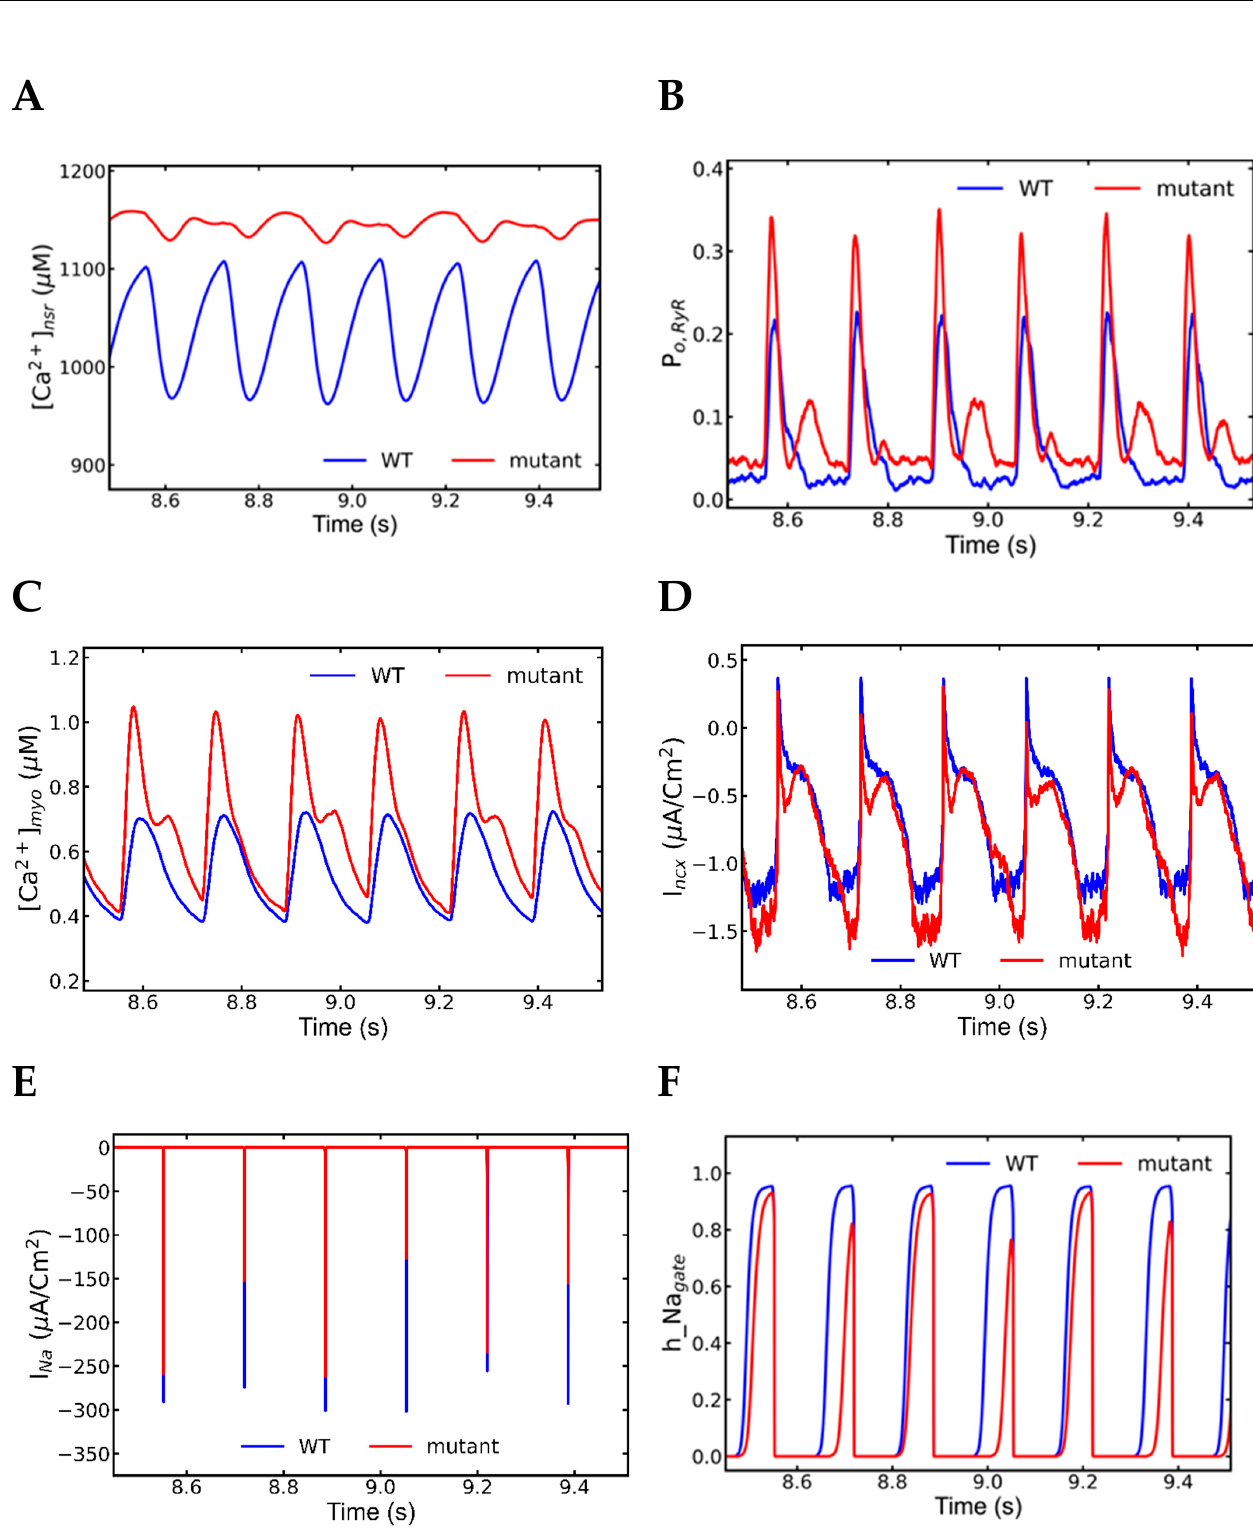
Figure 11. Alternate ionic currents and Ca 2+ transients can have an alternate pattern. A detailed plots from a segment 8.5-9.5 sec displayed those patterns in different ionic elements (wild-type—blue, mutant—red). ( A ) NSR Ca 2+ concentration ( B ) Opening probability of RyR2 channels, ( C ) Myoplas- mic Ca 2+ concentration ([Ca 2+ ] myo ), ( D ) Na + -Ca 2+ exchange current (I ncx ), ( E ) Na + current (I Na ), ( F ) Na + inactivation h-gate. The simulation was repeated 10 times with different seeds for the pseudo ran- dom number generator and the patterns observed were repeated each time. Shown here is a repre- sentative simulation.